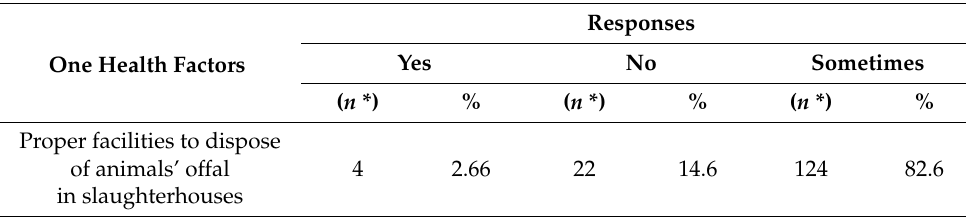
Table 4. Interview results including 150 slaughterhouse employees at three urban slaughterhouses in Rawalpindi